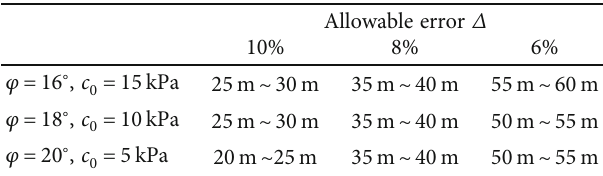
Figure 6: Variation laws of the relative error of di ff erent parts supporting pressure: (a) φ = 16 ° , c = 15kPa ; (b) φ = 18 ° , c = 10kPa ; and (c) φ = 20 ° , c = 5kPa . Table 2: Boundary depth of shallow tunnels under the in fl uence of soil heterogeneity and pore